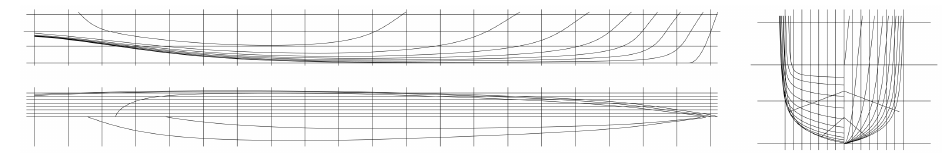
Figure 1. Linesplan